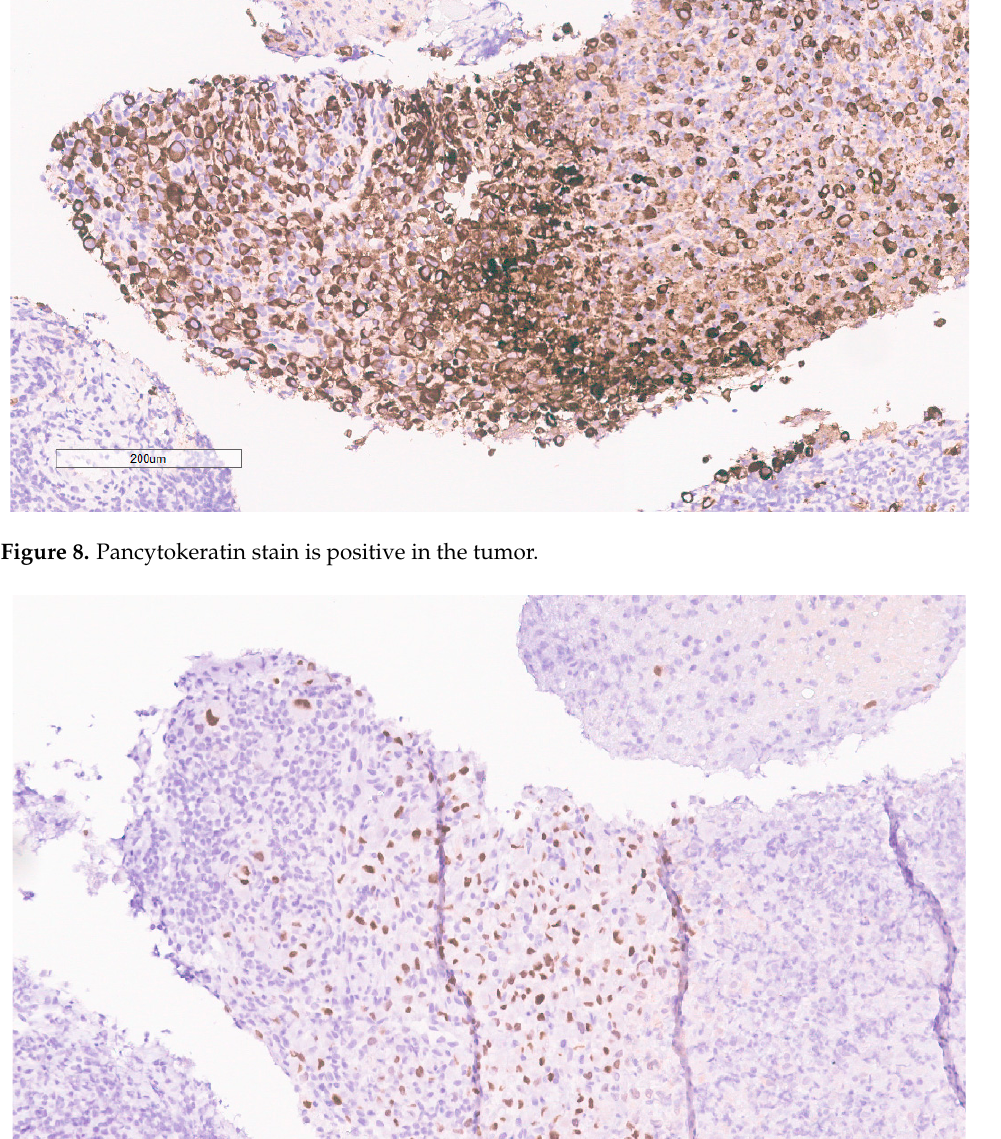
Figure 9. PAX8 is positive in the tumor.